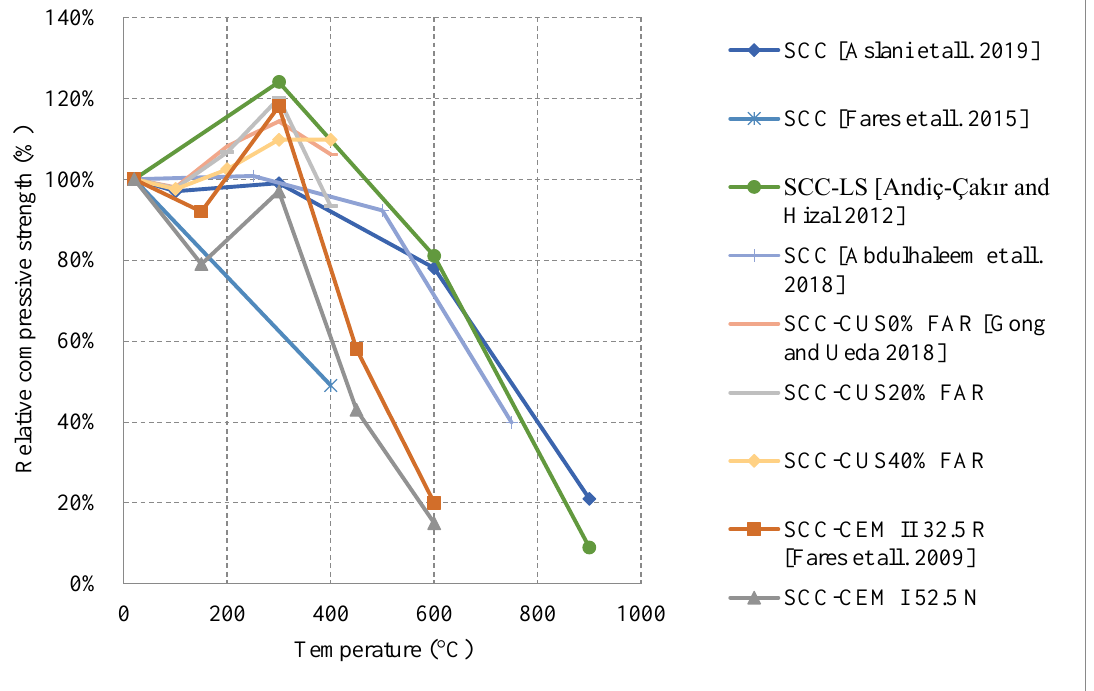
Figure 31. Relative compressive strength of naturally cooled SCC with different constituents. LS: Limestone, CUS: Copper Slag, FAR: Fine Aggregate Replacement [75,101–105].